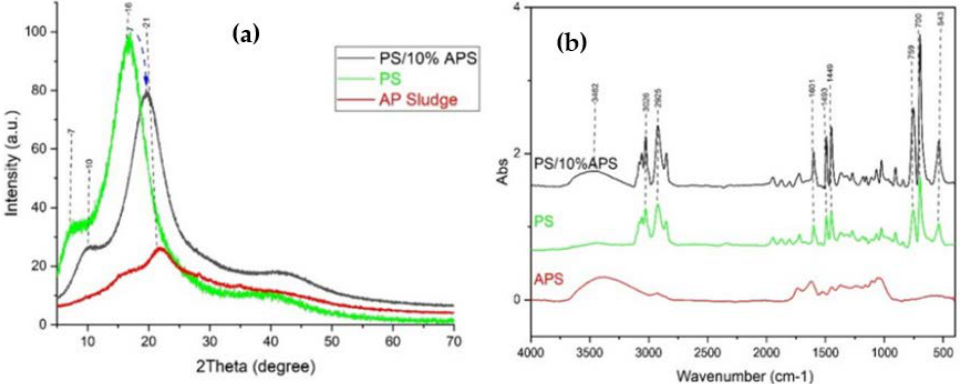
Figure 11. ( a ) X-ray of PS, AP sludge, and PS/AP sludge, ( b ) FTIR spectra of PS AP; sludge, and PS/AP